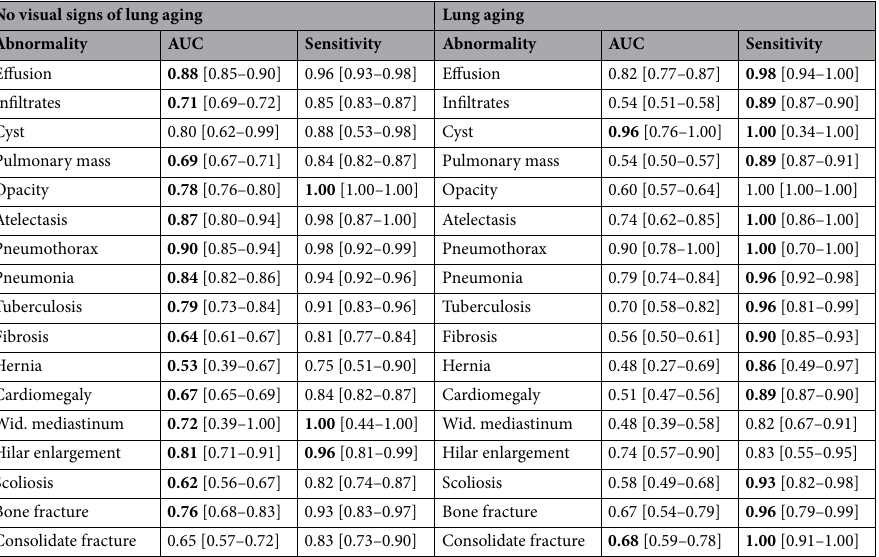
Table 3. The results of proposed framework presented in terms of the area under the receiving operator curve and sensitivity against patients with and without sings of lung aging marked by the attending radiologists. The higher number for each abnormality is highlighted in